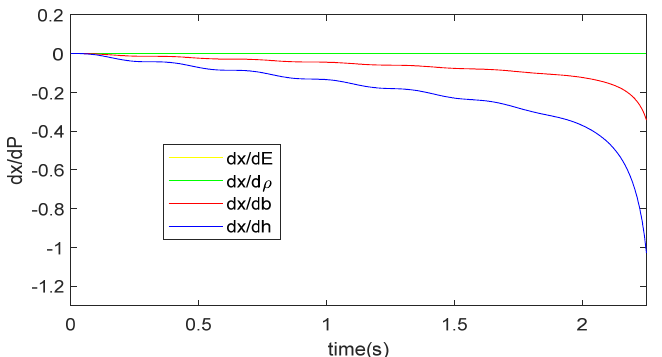
Figure 12. The sensitivity of the solution x with respect to the design parameters E , ρ , b and h .